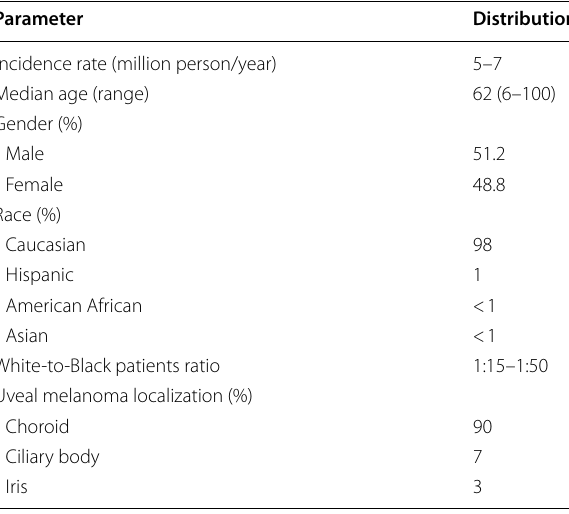
Table 1 Epidemiological data of uveal melanoma Parameter